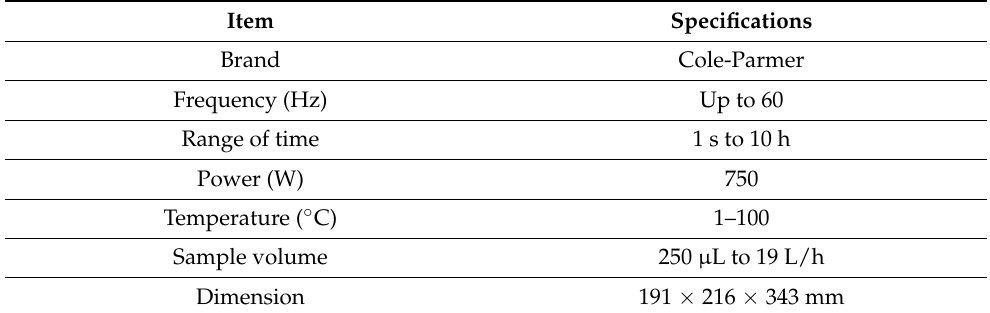
Figure 1. Ultrasonic probe system setup. Table 1. Specification of ultrasonic processor.